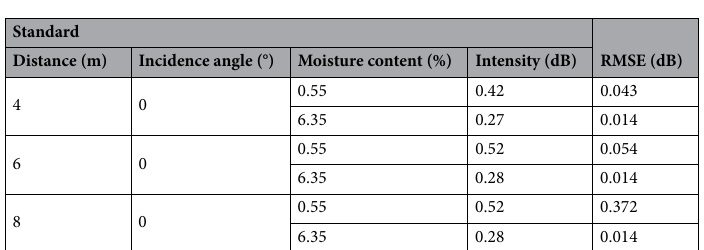
Table 5. Performance of the correction models as evaluated by the RMSEs.